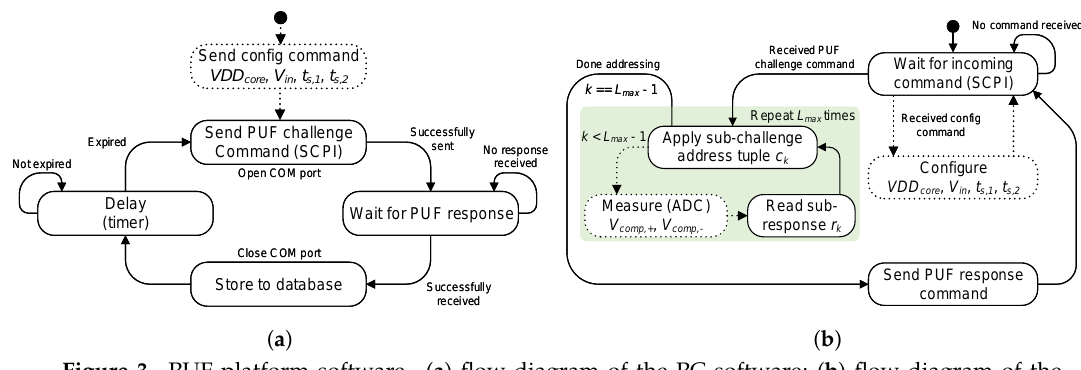
Figure 3. PUF platform software. ( a ) flow diagram of the PC software; ( b ) flow diagram of the microcontroller software (simplified).